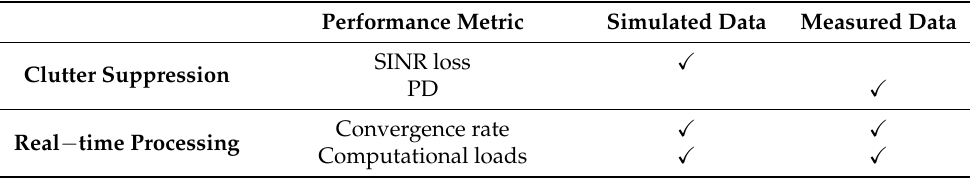
Table 2. Summary of Performance